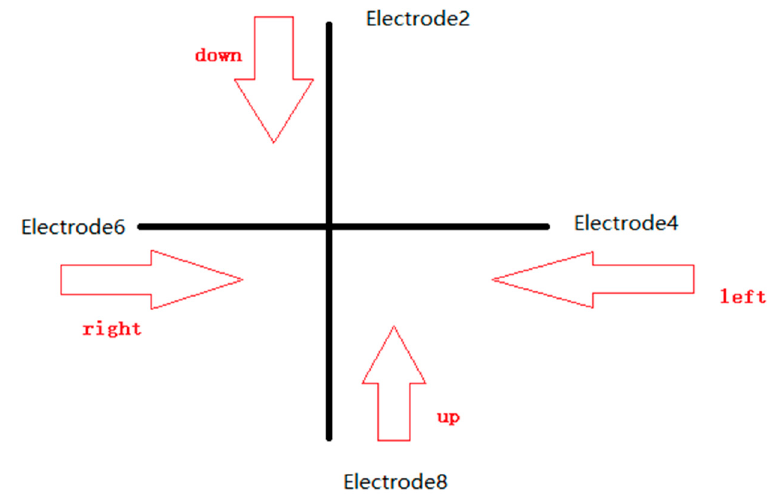
Figure 11. Schematic diagram of direction input. Table 3. Feature pairs of direction input.